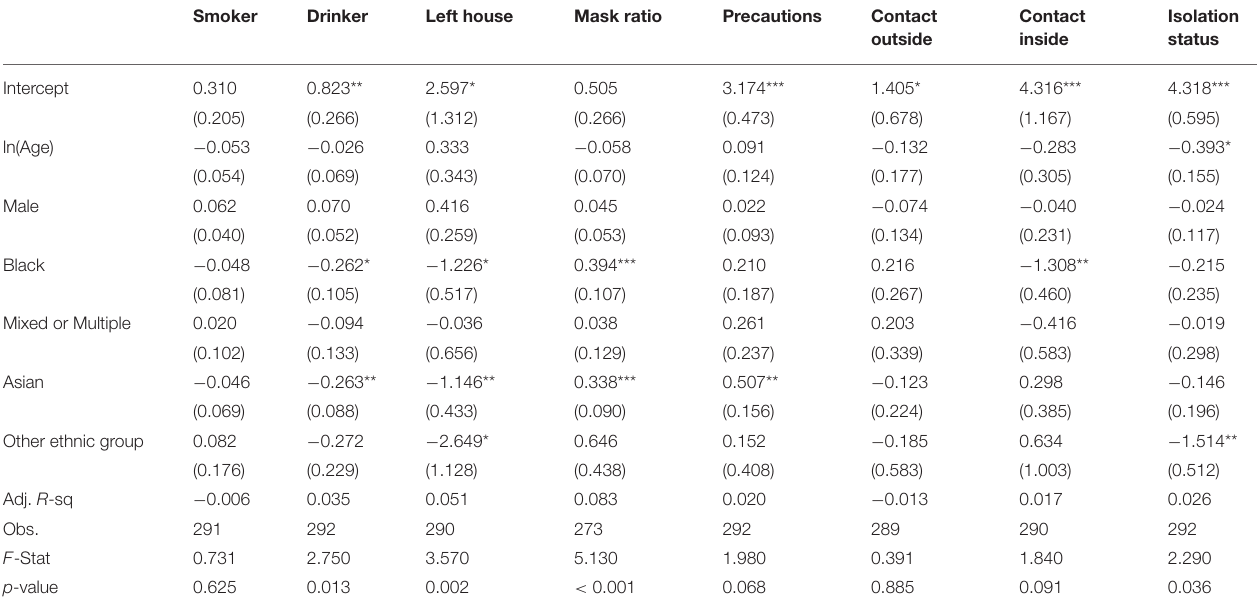
TABLE 3 | Correlation analysis—Pearson correlation coefficients for the main risk measures for study 2. Study 2 DOSPERT